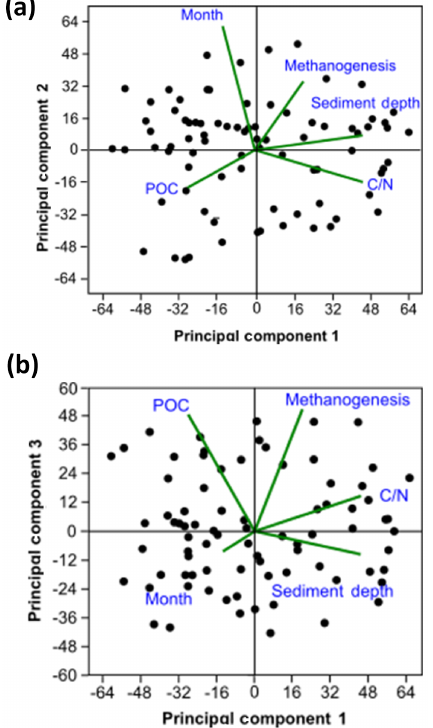
Figure 11. Principal component analysis (PCA) from two different angles of net methanogenesis depth profiles and sampling month (Month), sediment depth, and depth profiles of particulate organic carbon (POC) and C / N ratio (C / N). Data were transformed into ranks before analysis. (a) Correlation biplot of principal compo- nents 1 and 2 and (b) correlation biplot of principal components 1 and 3. Correlation biplots are shown in a multidimensional space with parameters shown as green lines and samples shown as black dots. Parameters pointing in the same direction are positively re- lated; parameters pointing in the opposite direction are negatively